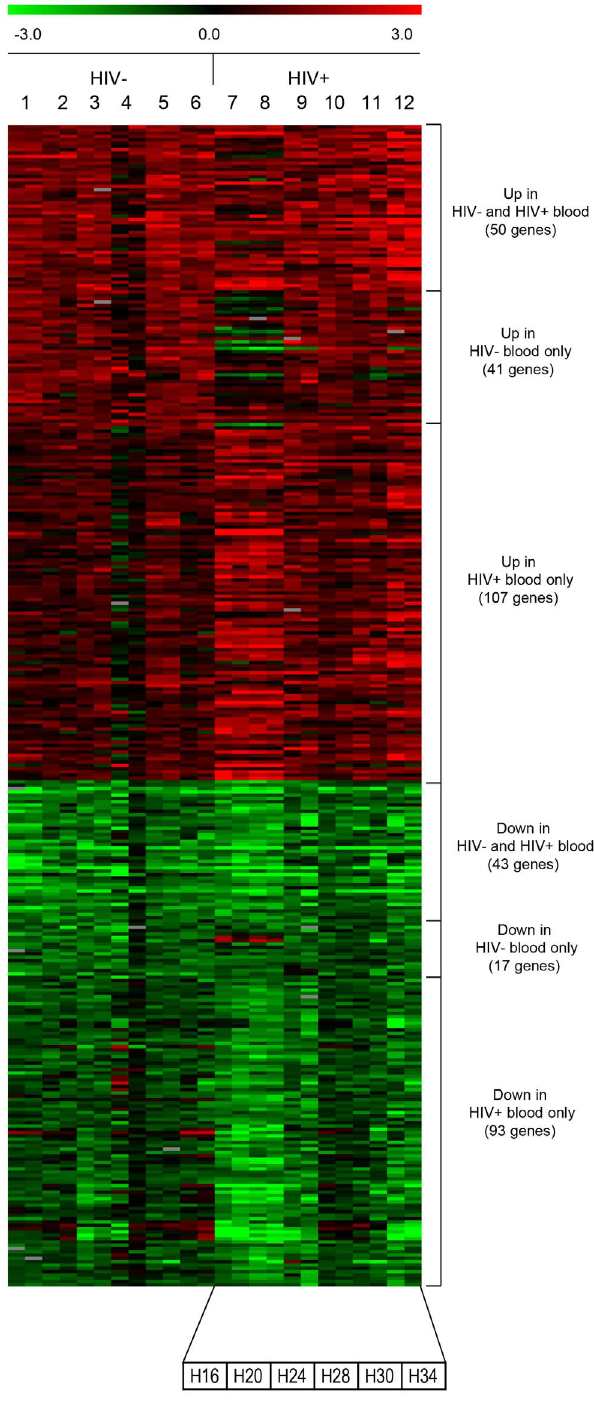
Figure 2. Differentially expressed M.tb genes in whole blood from HIV- and HIV + donors. Heat map denoting upregulated genes in red and down-regulated genes in green in M. tb grown in blood from 6 HIV- donors (1-6) and 6 HIV + patients (7-12) with dye flip (12 samples for each condition, HIV- and HIV + ). Genes are listed as upregulated or down-regulated in blood from both HIV- and HIV + donors or in HIV- donor blood only or HIV + patient blood only. HIV + blood sample codes (H # ) are listed at the bottom for comparison with CD4 + T cell counts and viral loads in Table S1.